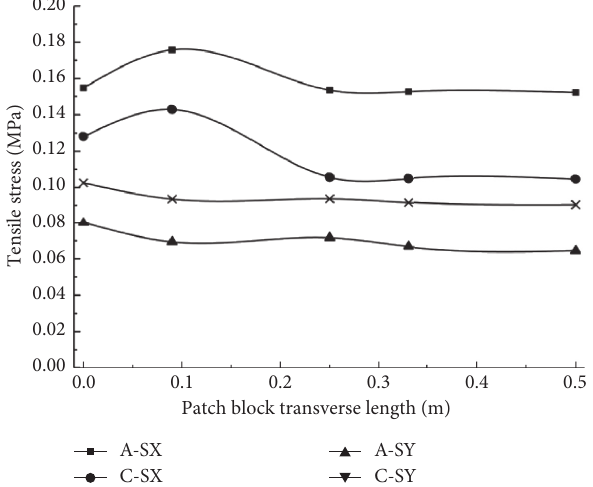
Figure 5: The effects of longitudinal movement of different loading positions on tensile stress of patch block.